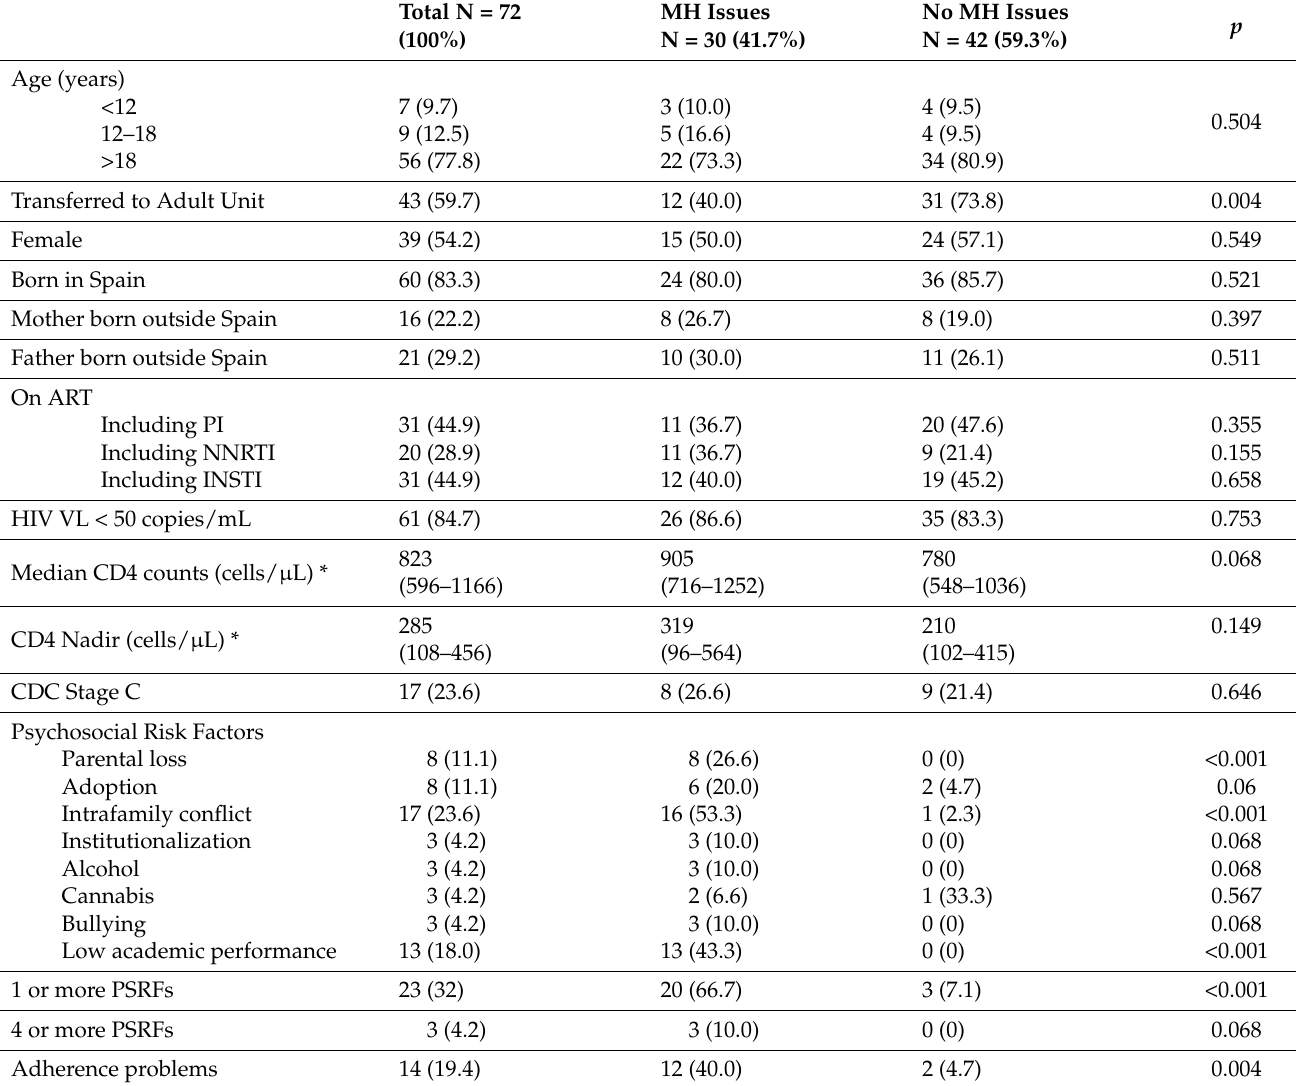
Table 1. Characteristics of the study